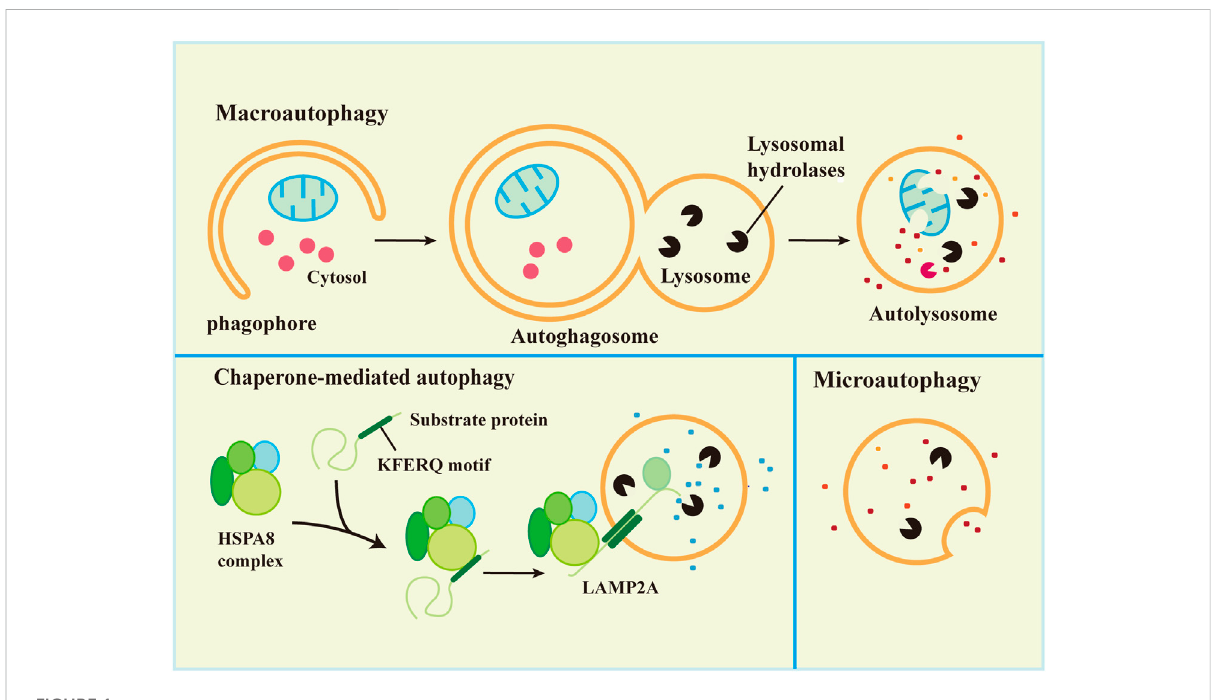
FIGURE 1 Types of autophagy in mammalian